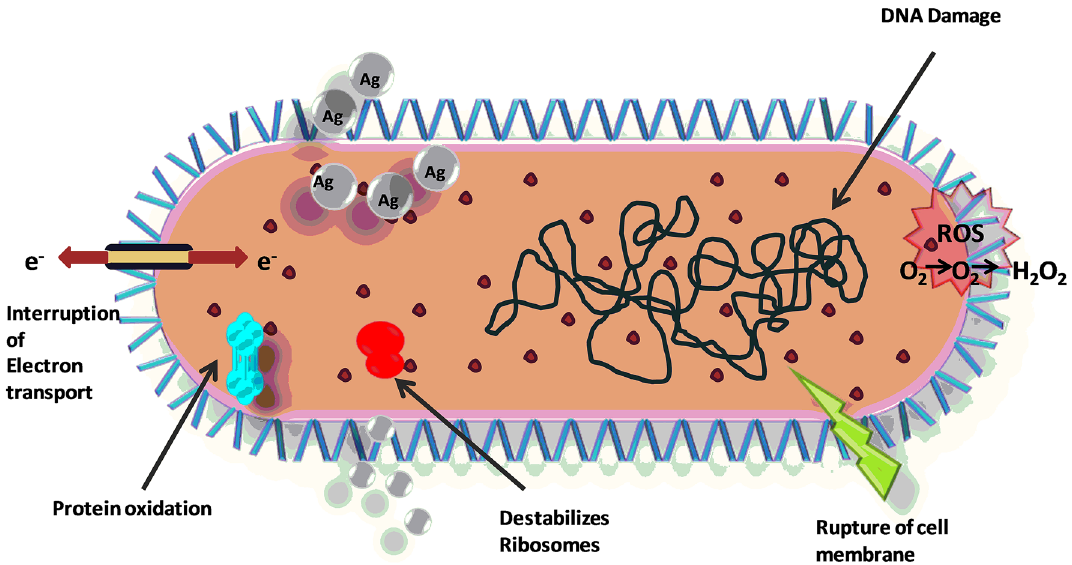
Fig. 7 Possible antibacterial activity mechanism of